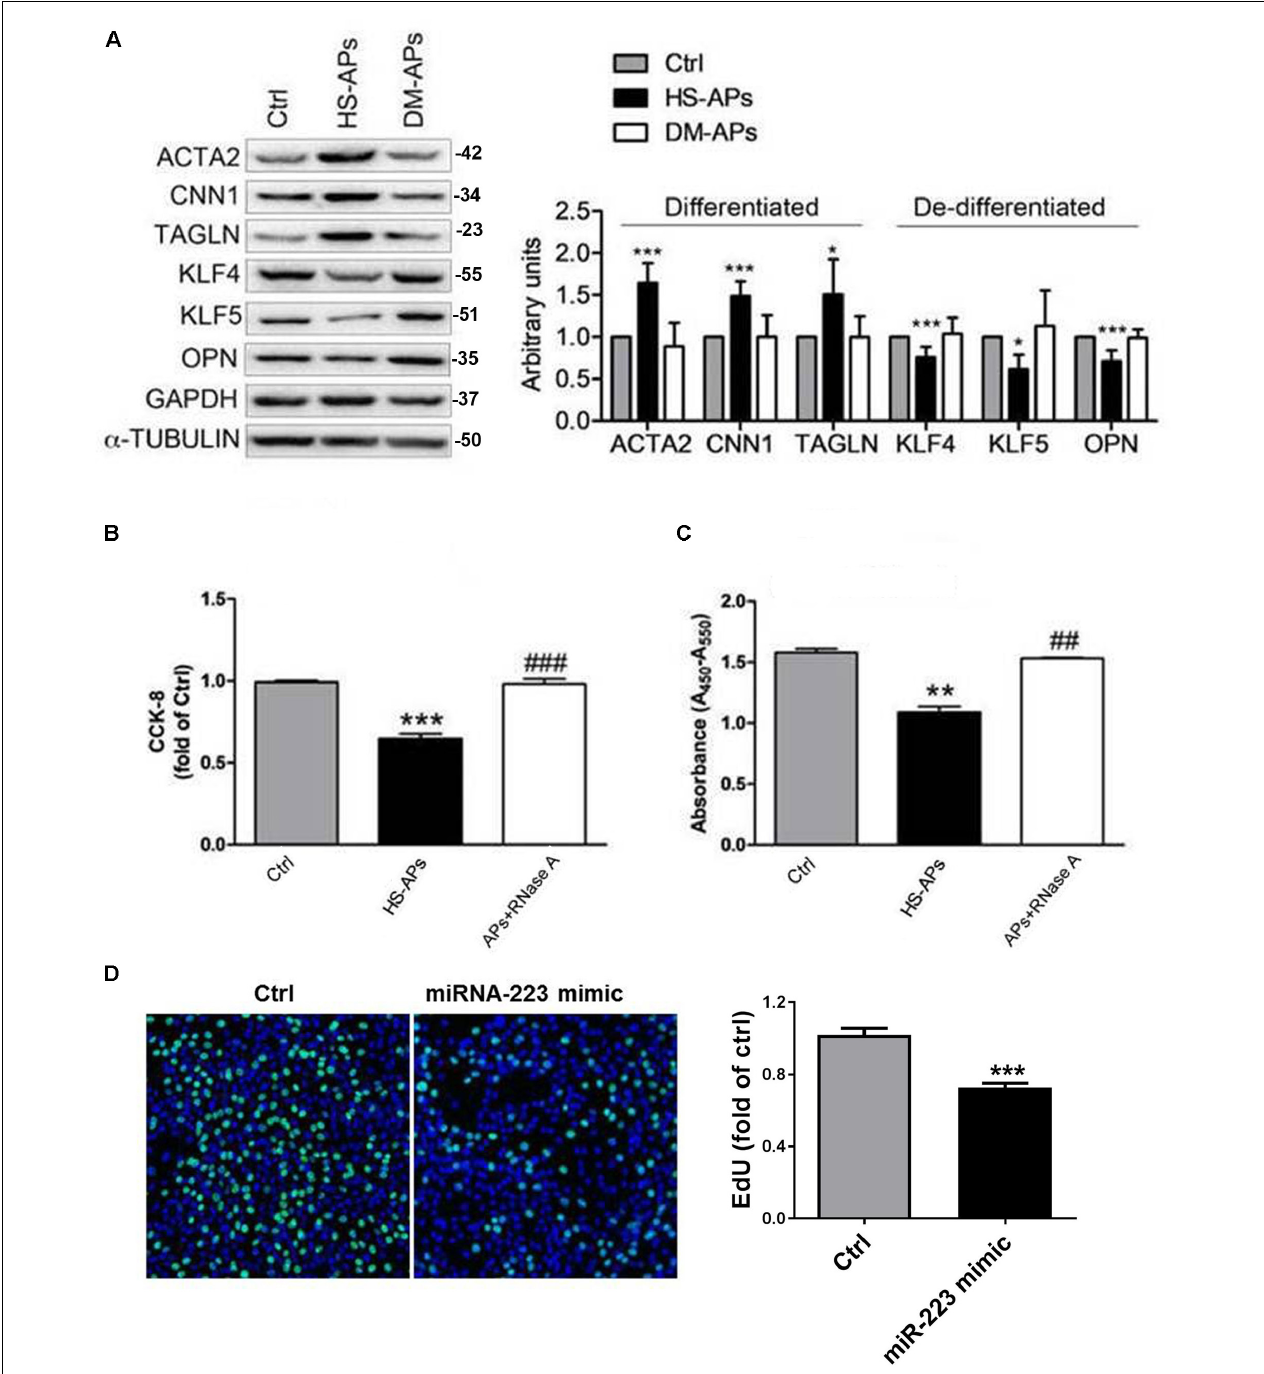
FIGURE 1 | MiR-223 deficiency in diabetic platelet fails to suppress VSMC proliferation. Activated platelets (APs) from healthy subject (HS) and DM patients were cocultured with human VSMCs for 48 h. (A) Expression of differentiation markers ACTA2, CNN1, and TAGLN and dedifferentiation markers OPN, MYH10, KLF4, and KLF5 in control (Ctrl) VSMCs and APs cocultured with VSMCs (HS-APs, DM-APs) was detected with western blot analysis. (B,C) The rate of proliferation was determined by CCK8 assay and Brdu assay in VSMCs treated with APs pretreated by RNase A (degrades the RNA). Data are presented as mean ± SD ( n = 6). Comparisons between more than two groups were analyzed using one-way ANOVA analysis with the Dunnett’s multiple correction. * P < 0.05, ** P < 0.01, *** P < 0.001 vs Ctrl (VSMCs without platelets); # P < 0.05, ## P < 0.01, ### P < 0.001 vs HS-APs. (D) The rate of proliferation was determined by EdU incorporation assay in VSMCs transfected with miR-223 mimic. Data are presented as mean ± SD ( n = 6). Comparisons between two groups were analyzed using unpaired nonparametric Student’s t -test.* P < 0.05 vs Ctrl (miR-NC).